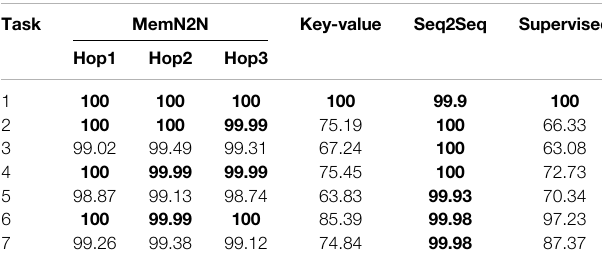
TABLE 8 | The test set results of the Barista Dataset with 10,000 dialogues. The best performing methods (or methods within 0.1% of best performing) are given in bold for the per-response accuracy metric. The results show that on average and for task 8 (containing all tasks), Seq2Seq is the best performing